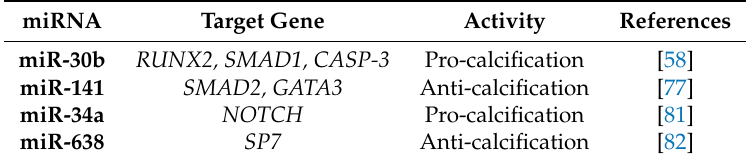
Table 2. List of miRNAs implicated in mechano-dependent onset of calcific aortic valve disease (CAVD). miRNA Target Gene